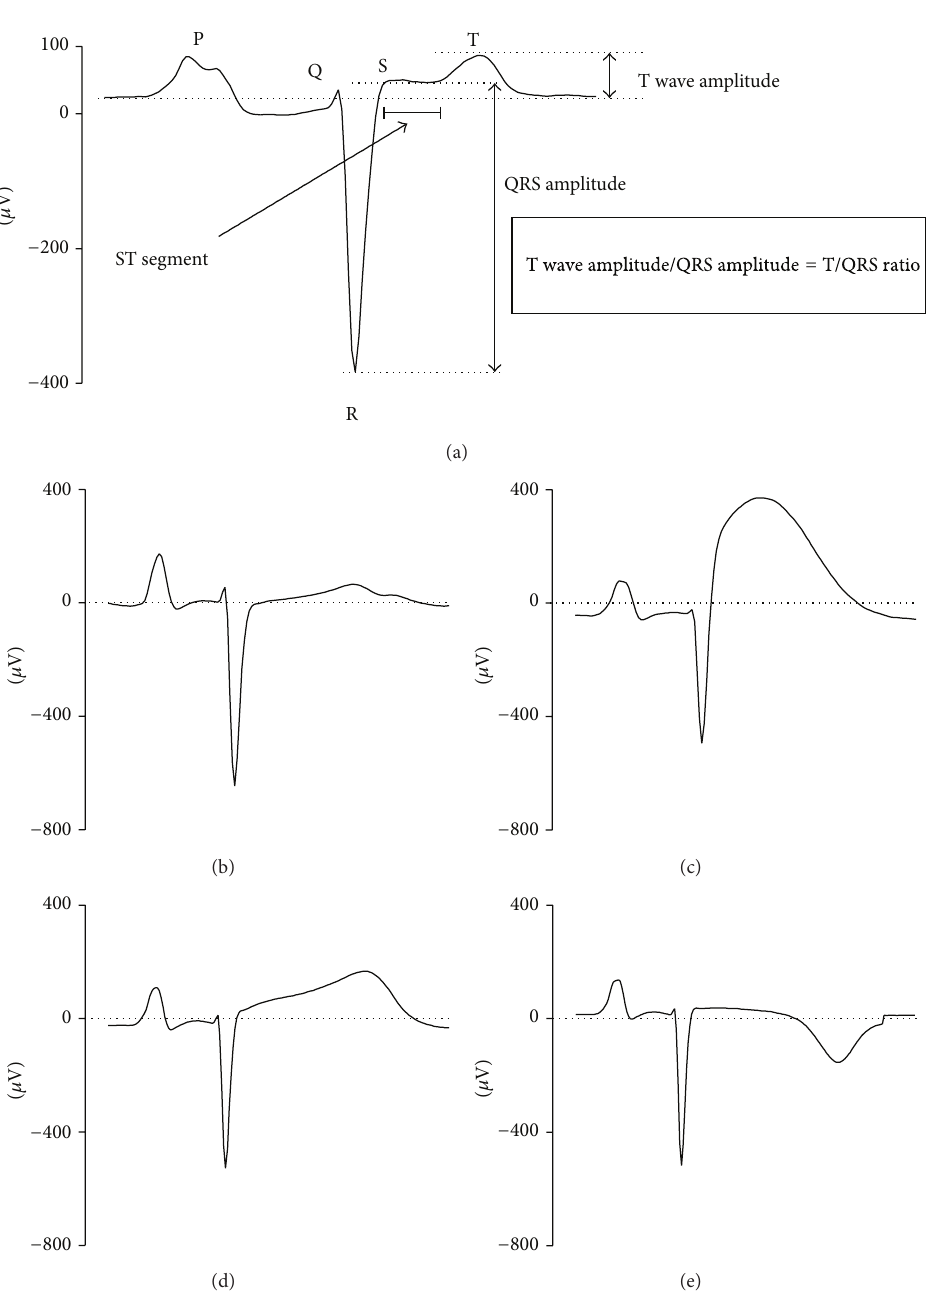
Figure 1: Examples of the ECG complex taken from a 0.7 gestation fetus. (a) A representative fetal ECG complex with identification of the ST segment, T wave amplitude, and QRS amplitude. The T/QRS ratio is calculated for each complex by division of the T wave amplitude by the QRS amplitude, thus correcting for changes in signal gain from electrode placement and fetal movement. (b) The ECG complex during the baseline period. (c) Characteristic ST segment elevation early during the occlusion when the fetus is compensating well. (d) Gradual reduction in ST segment elevation concordant with a fall in T/QRS ratio as the fetus starts to compromise from prolonged asphyxia. (e) Progressive T wave inversion immediately after prolonged severe